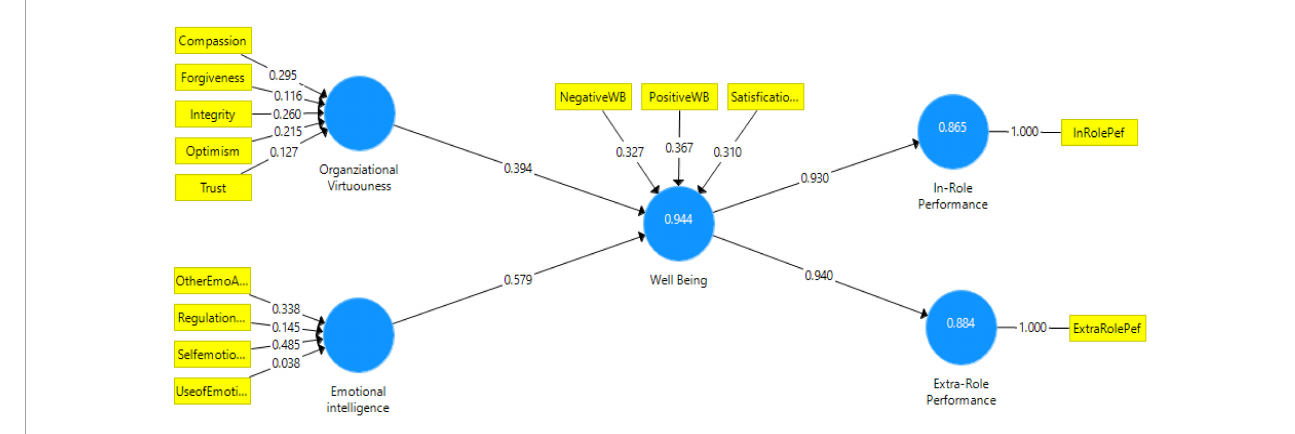
FIGURE4 Second-order structural model.